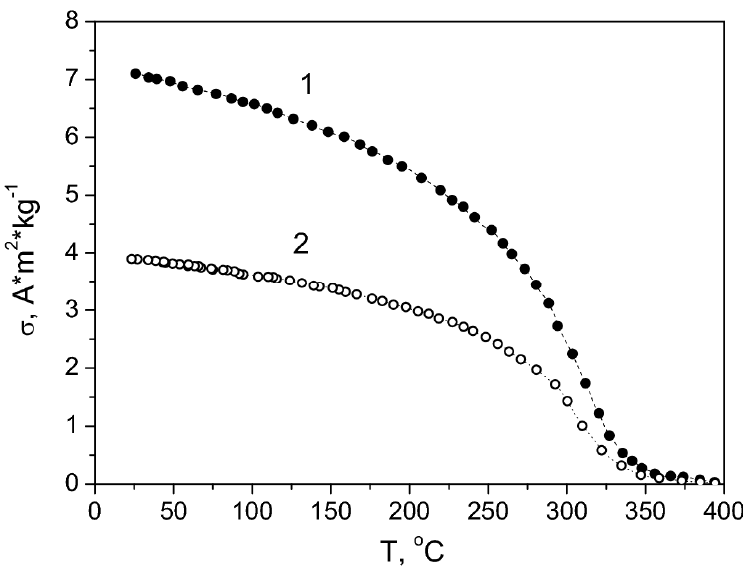
Figure 4. Temperature behavior of specific saturation magnetization for the samples ACB-Ni (1) and ACC-Ni (2) measured at a magnetic field intensity of 800 kA/m.